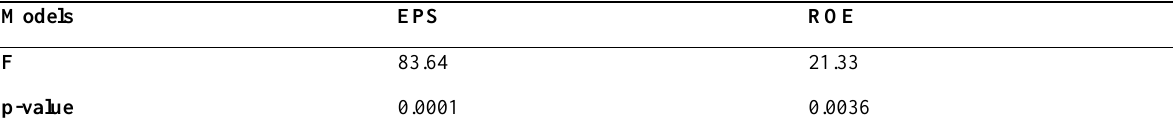
Table-8: Summary of the output of Wooldridge Test for Autocorrelation